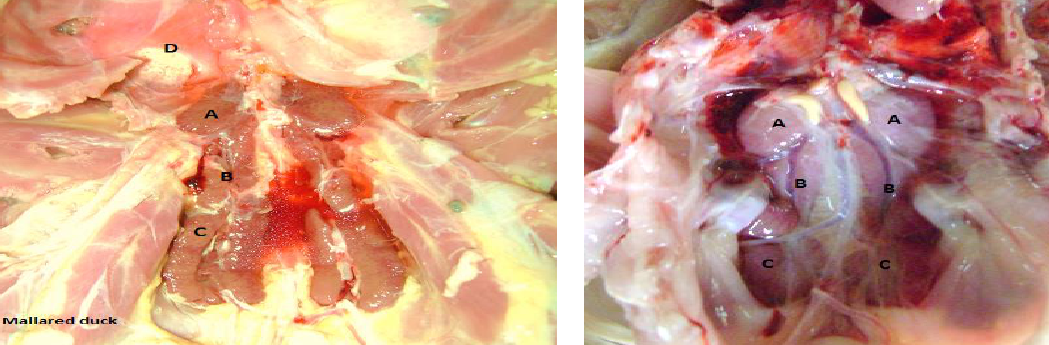
Figure, 4: anatomical specimen of chicken shows: ( A) Kidneys cranial lobe, (B) Kidneys middle lobe, (C) Kidneys caudal lobe.